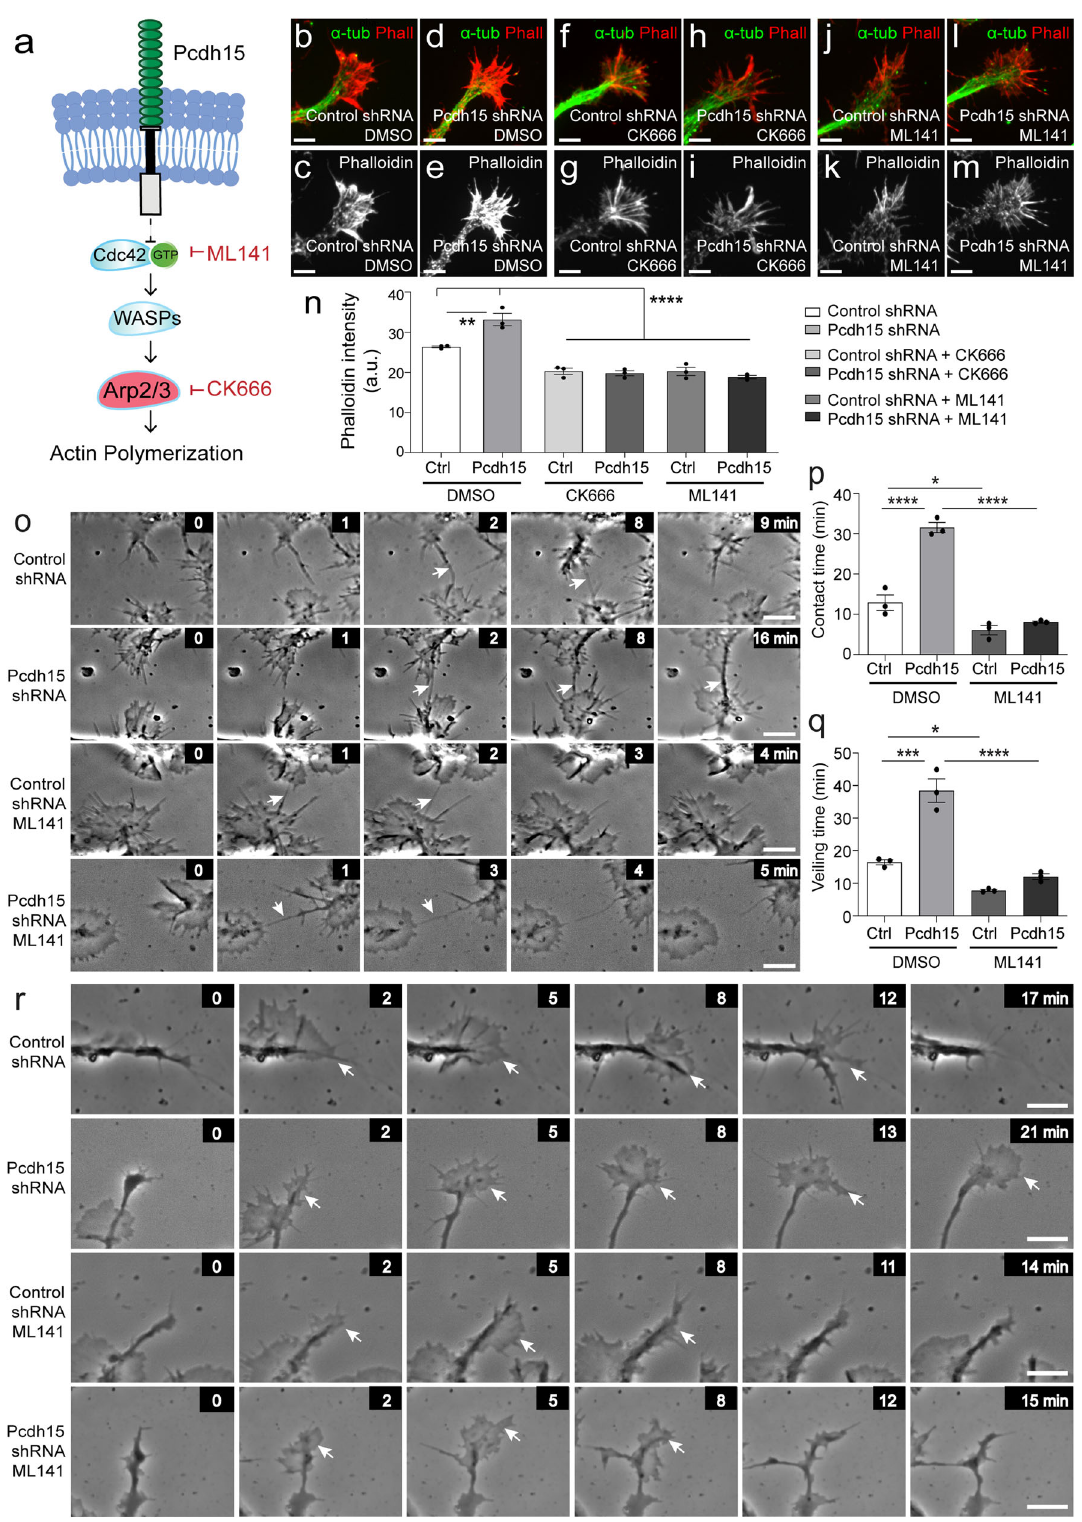
INTACT nuclear RNA isolations . Cre-inducible Sun1-eGFP transgenic mice were crossed with Ng2-CreER T2 or PLP1-CreERT transgenic mice to generate Ng2- CreER T2 :: Sun1-eGFP or PLP1-CreERT:: Sun1-eGFP mice, respectively. Tamoxifen (20 mg/kg) was delivered to adult mice (18-22 weeks) daily for 5 consecutive days, to induce expression of the Sun1-eGFP transgene in NG2 + OPCs or PLP + OLs. Brains were harvested two days later and Sun1-eGFP + nuclei were af fi nity puri fi ed using anti-GFP (Abcam 13970) and magnetic beads (Dynabead) 95 . Nuclear RNA was converted to cDNA and libraries were generated using the Clonetech